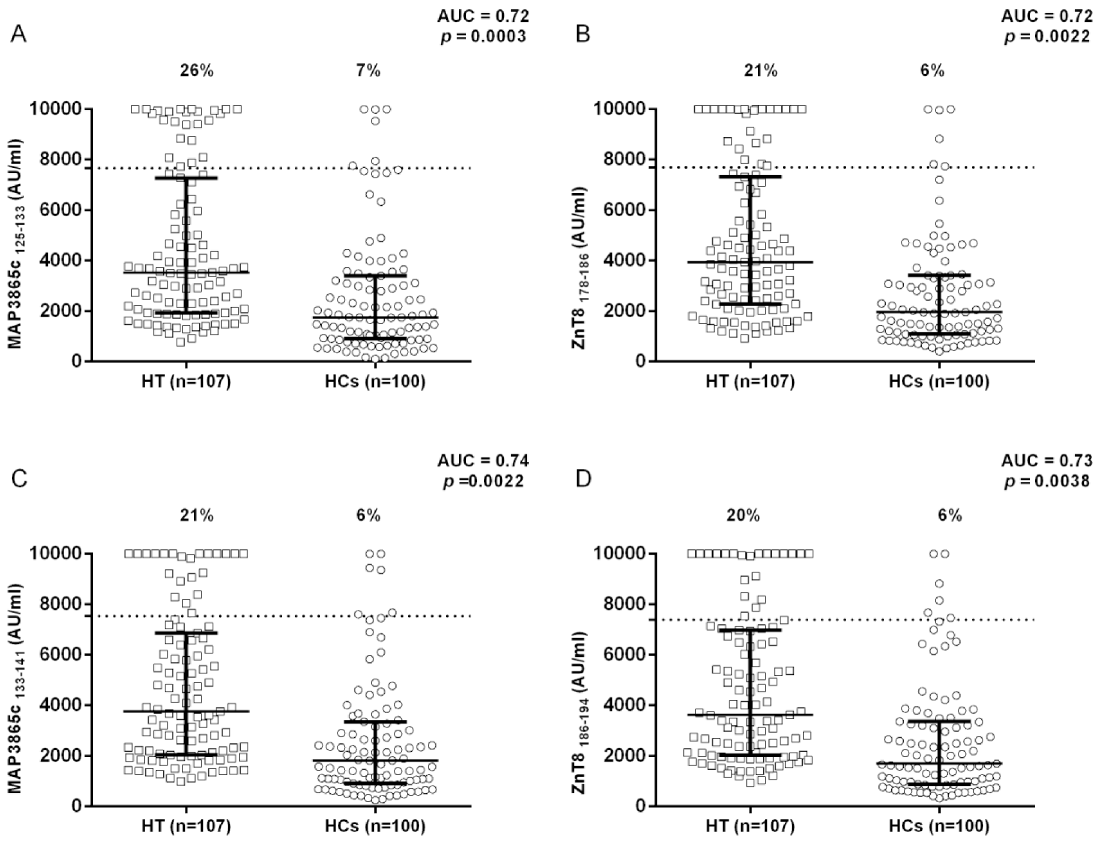
Figure 1. Scatter plot representation of ELISA values in Hashimoto’s thyroiditis patients compared to healthy controls. Scatter plots for MAP3865c 125–133 ( A ) and its homologous ZnT8 178–186 ( B ) and MAP3865c 133–141 ( C ) and its homologous ZnT8 186–194 ( D ) representing the IgG antibodies distribution against these epitopes in Hashimoto’s thyroiditis patients and healthy subjects. The number of serum samples in each group is indicated. Dotted lines indicate the cutoff, while bars indicate the corresponding median 6 interquartile range. The percent fraction of antibody positive sera is indicated on top of each distribution, whereas AUC and p values are given in the top right